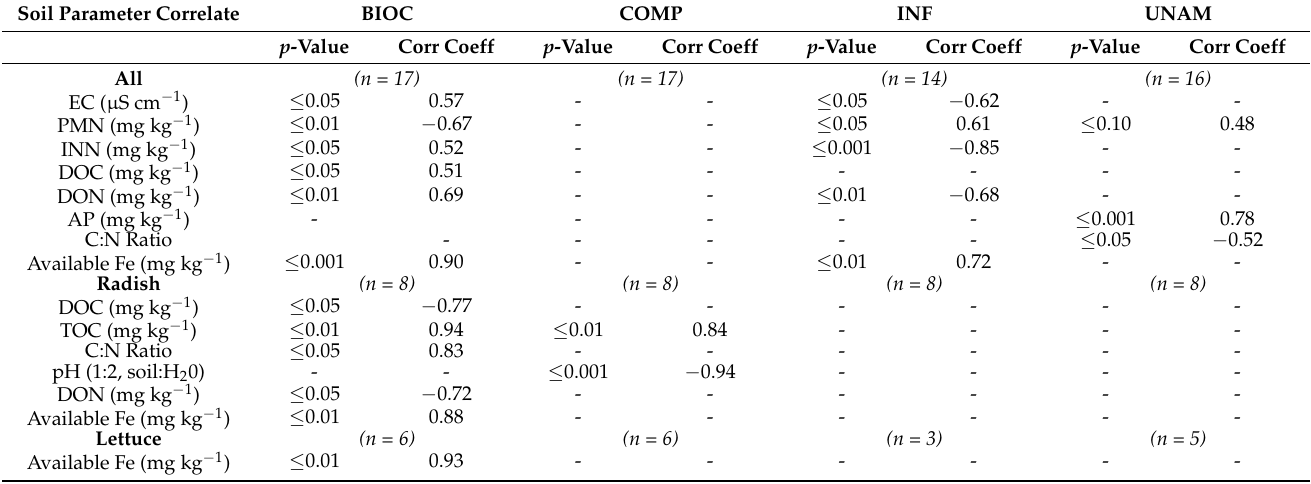
Figure 4. Correlation between soil pH and available soil lead (Pb) among radish (R) and lettuce (L) samples. Colors represent different treatments (biochar, BIOC; compost, COMP, inorganic fertilizer, INF; and unamended control, UNAM) and shapes represent different life forms (diamond for lettuce and circle for radish). Statistical analysis was conducted using Pearson’s correlation test and observations were considered significant at p ≤ 0.05. Table 6. p -Values and significant values of correlation coefficients representing relationships between soil available lead (Pb) and pH, electrical conductivity (EC), potentially mineralizable N (PMN), inorganic N (ammonium and nitrate, INN), dissolved organic nitrogen (DON), dissolved organic carbon (DOC), available phosphorous (AP), C:N ratio, and available iron (Fe) for both plant species, plus lab incubated soil (All) or Radish and Lettuce separately in soils amended with biochar, BIOC; compost, COMP, inorganic fertilizer, INF, and unamended control, UNAM. Statistical analysis was conducted using Pearson’s correlation test and observations were considered significant at p ≤ 0.05 and analyses were performed on number of observations as indicated in brackets below the column